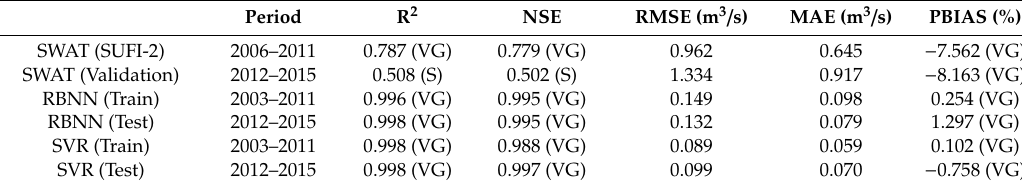
Table 8. Performance criteria of SWAT model and artificial intelligence (AI)